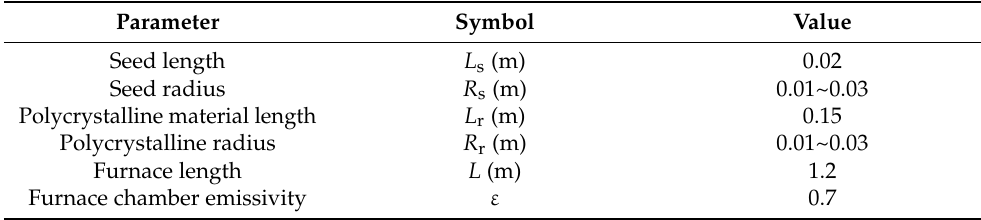
Table 3. Geometric parameters of the crystal growth system.